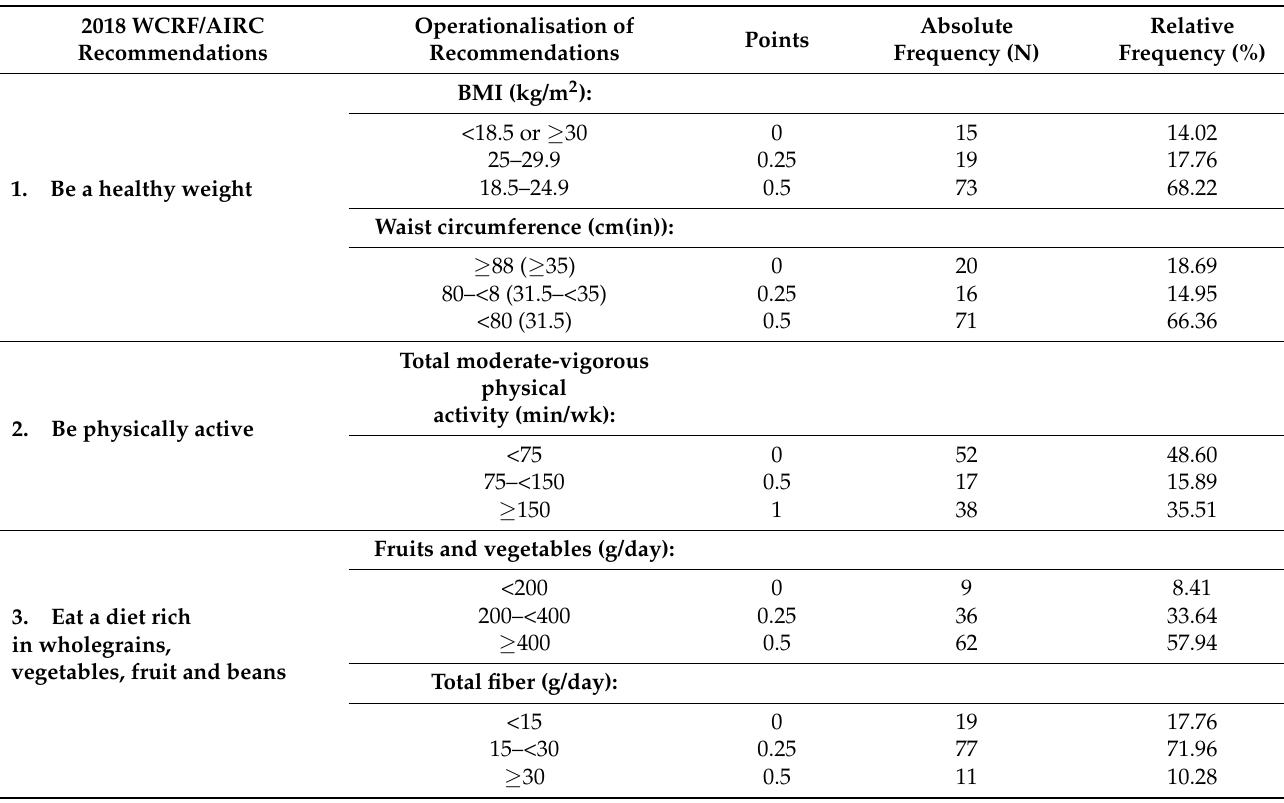
Table 3. 2018 WCRF/AICR recommendations for cancer prevention and operationalization of the WCRF/AICR score in the 107 participants of DAMA25